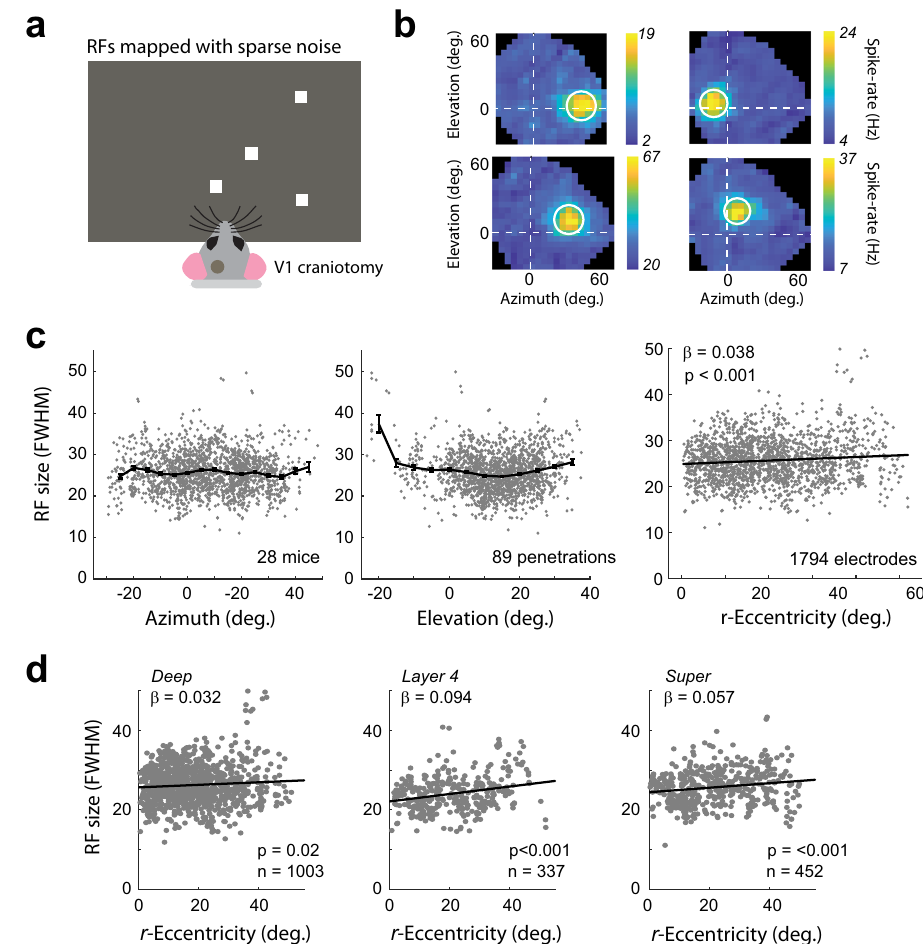
Fig. 2 Electrophysiological analysis of RF size. a A total of 28 awake Thy1-5.17-GCaMP mice viewed sparse-noise RF mapping stimuli while multi-unit neural activity was measured across the different layers of V1 using a linear probe. b Four example RFs showing the average change in spiking in response to each check position. The white circle denotes the FWHM of the best- fi tting Gaussian. c The azimuth (left panel) and elevation (middle panel) of the RFs across all animals. The binned average (bin size = 5°) is shown as the black line. RF size was relatively constant across different azimuths/elevations with the exception of one penetration at a more negative elevation where RF sizes were larger. Right panel: the relationship between r-eccentricity (angle between the RF center and the focea in a spherical coordinate system) and RF size showed a weak, but signi fi cant positive relationship (Linear regression. H0: β = 0 (two-tailed)). Error bars indicate SEM. d The slope of the relationship between r-eccentricity and RF size was signi fi cant in the individual layers. The slope did not differ signi fi cantly across laminar compartments (ANCOVA, F 2,1786 = 3, p =